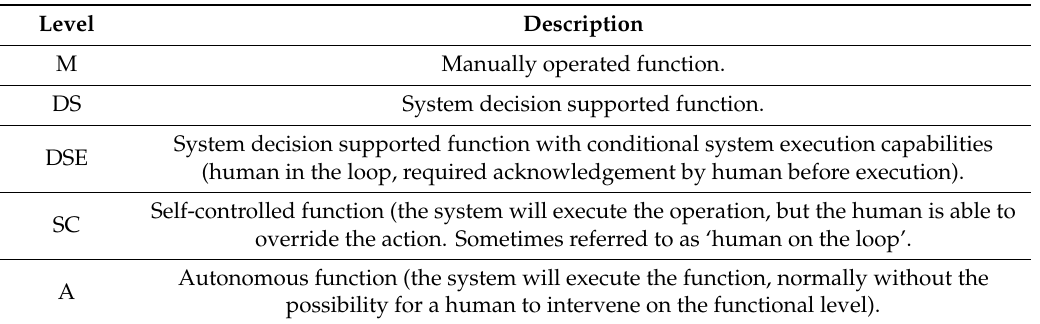
Table 4. MASS Levels of Control according to the Class Guideline for Autonomous and remotely operated ships by DNV GL. Reproduced with the permission from the authors of ‘Autonomous and remotely operated ships’, published by DNVGL-CG, Edition September 2018 [12] (p. 51).